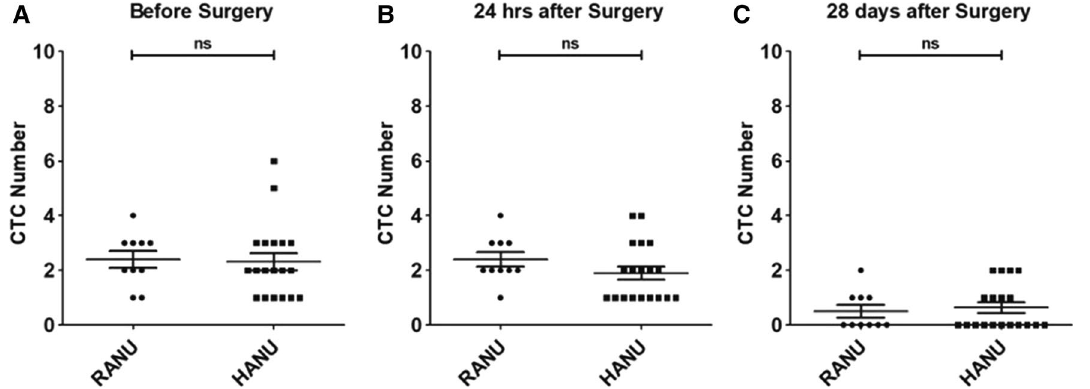
Figure 3. Correlation of CTC counts with different surgical techniques at various time points; ( A ) CTC counts before surgery; ( B ) CTC counts 24 h after surgery; ( C ) CTC counts 28 days after surgery; ns, not